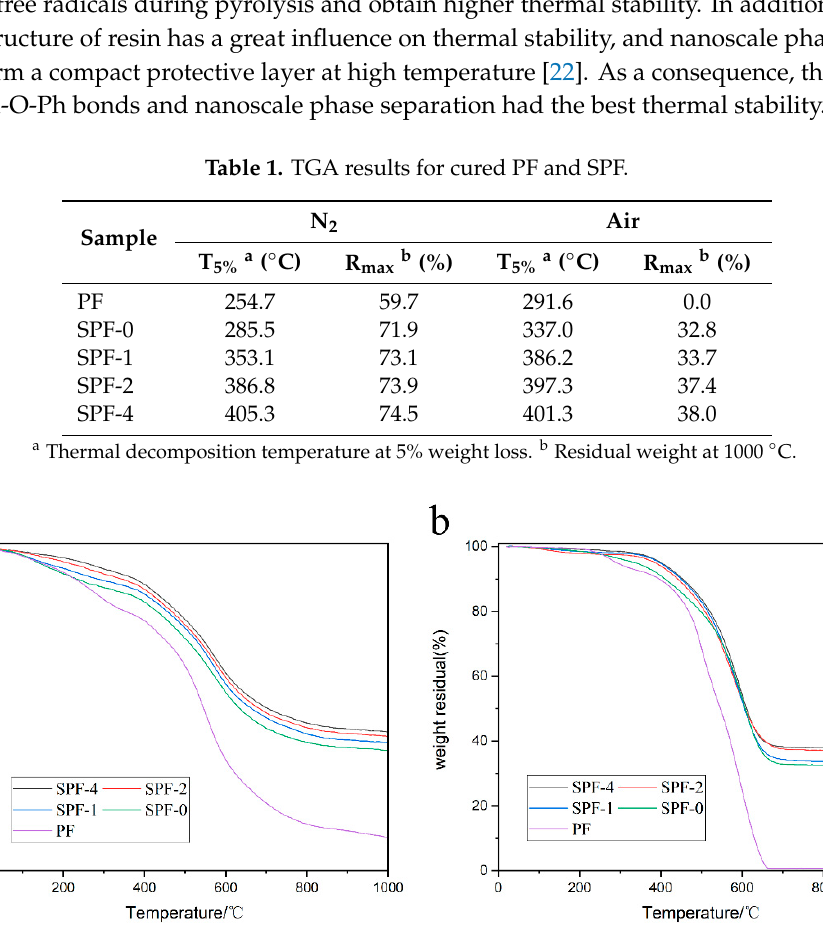
Figure 12. Schematic of the phase separation mechanism of SPF resins during curing.